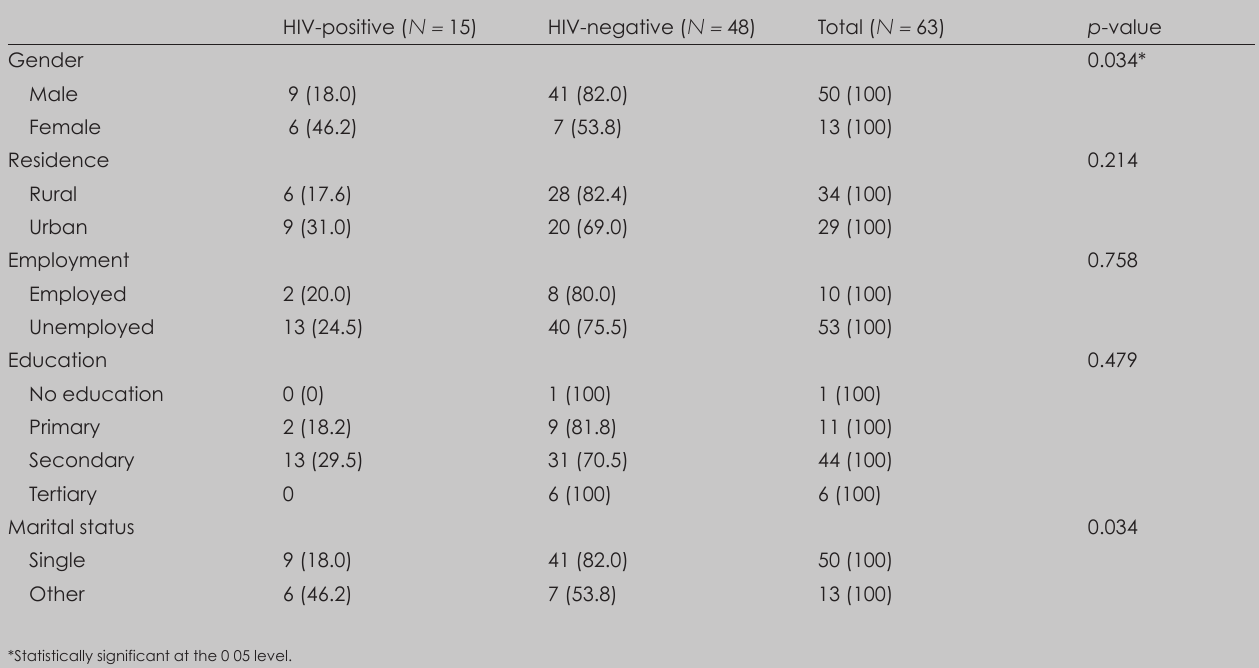
Table I. Demographic characteristics and HIV status of the sample (N